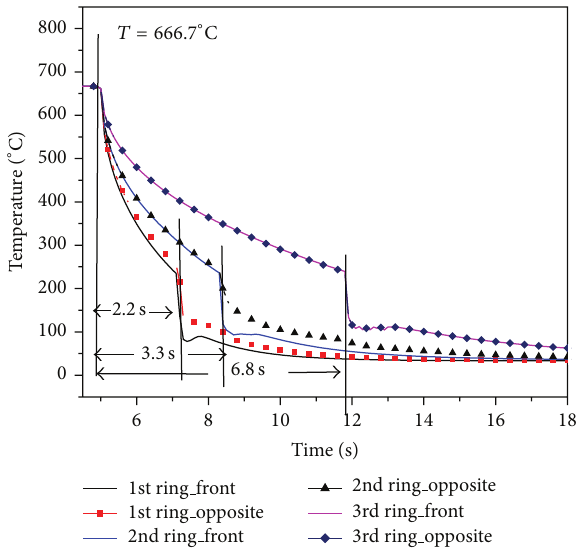
Figure 11: Influence of cross flow on rewetting of fuel surface temperature having uniform power.